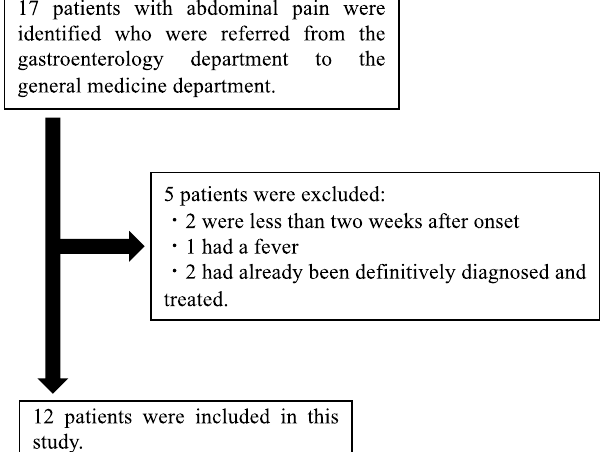
Figure 1. Flow diagram for the inclusion of patients in this study.